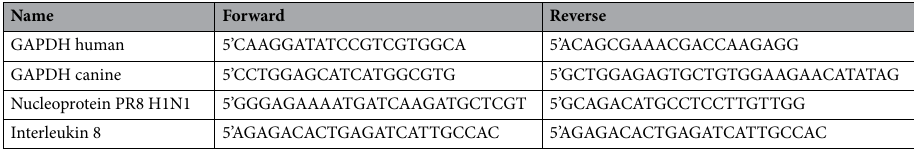
Table 2. Primers sequences used in this study for quantitative